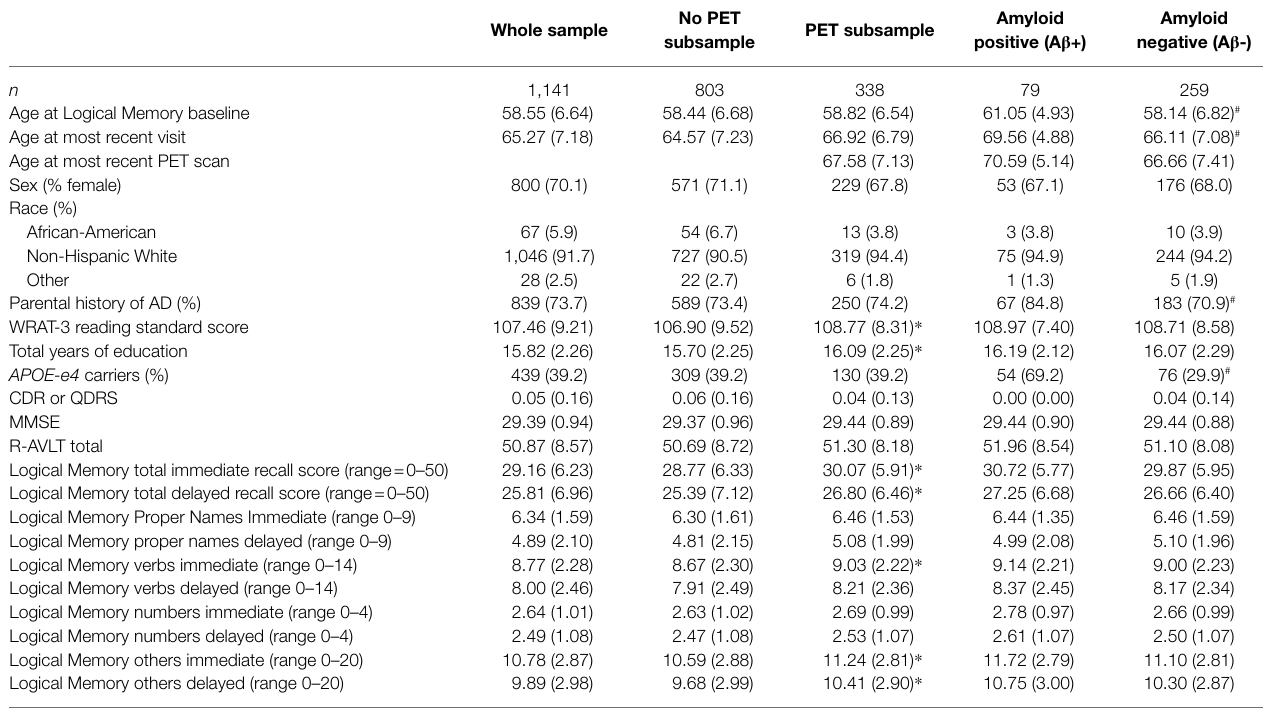
TABLE 1 | Demographic and clinical characteristics by total sample and subsample with amyloid imaging.